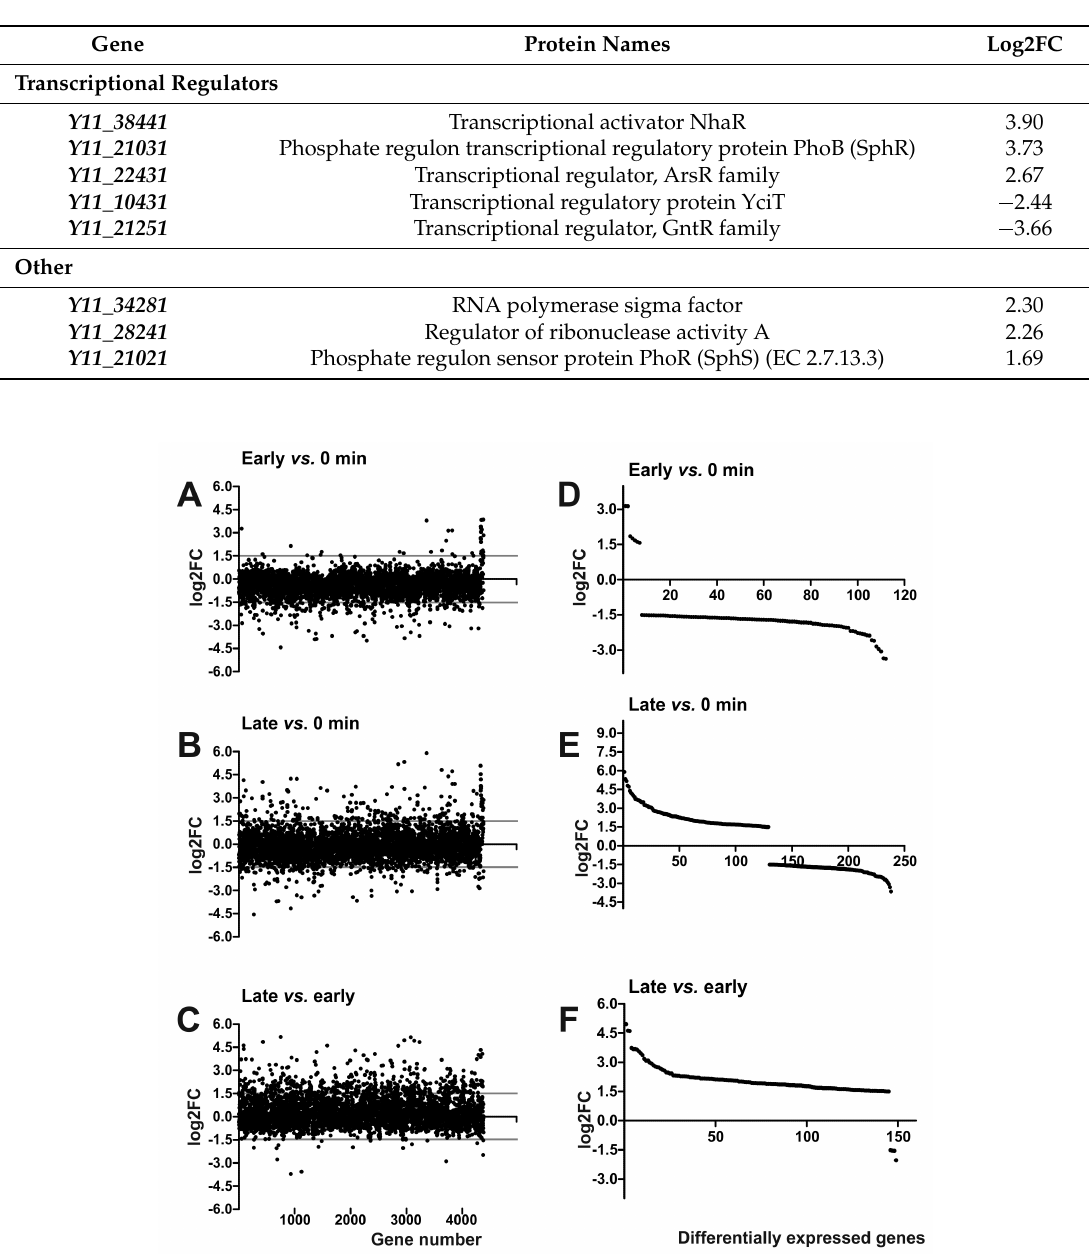
Figure 4. The change in the expression of the bacterial genes during the phage ϕ R1-37 infection cycle. The early phase values represent the average data calculated for the 2 and 5 min time points, and the late phase values, the average for the 28, 35, 42 and 49 min time points. Shown are the Log2FC values between the early phase and the negative control ( A ), between the late phase and negative control ( B ), and between the late and early phases ( C ). Each dot represents the Log2FC value calculated for each gene separately. In the A, B and C graphs, the dots are ordered according to their gene location in the YeO3-R1 genome (the consecutive gene numbers on the X-axis are indicated with the scale at the bottom). The grey lines indicate the selected differential expression threshold of (cid:8) 1.5. Panels D, E and F demonstrate that in the early phase most differentially expressed host genes are repressed ( D ), while in the late phase many differentially expressed host genes are activated ( E ) and this is even more pronounced when the late phase genes are compared to early phase genes ( F ). For panels D, E and F, the genes are arranged along the X-axis according to their decreasing log2FC